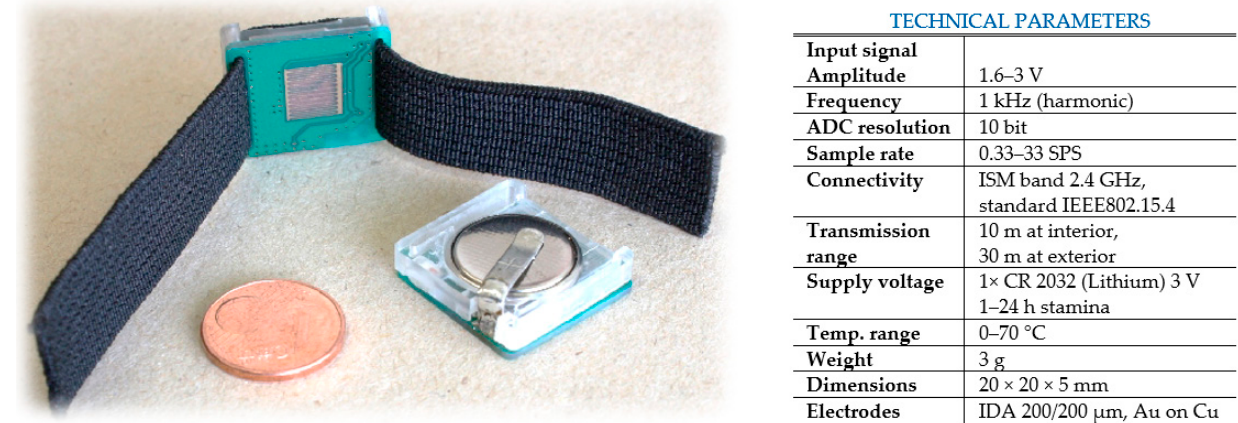
Figure 5. EDA-ring: design and technical parameters.